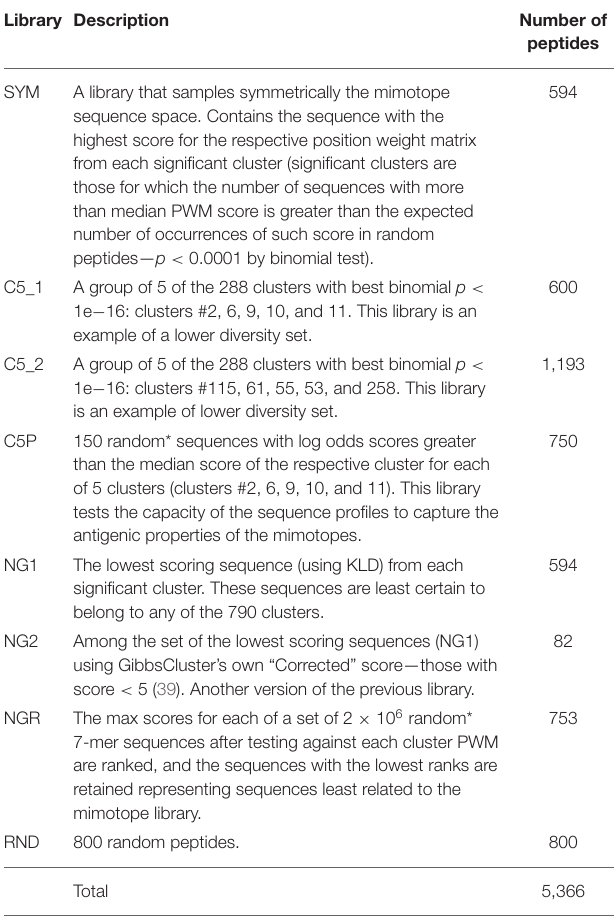
TABLE 1 | Libraries of 7-mer peptides studied.